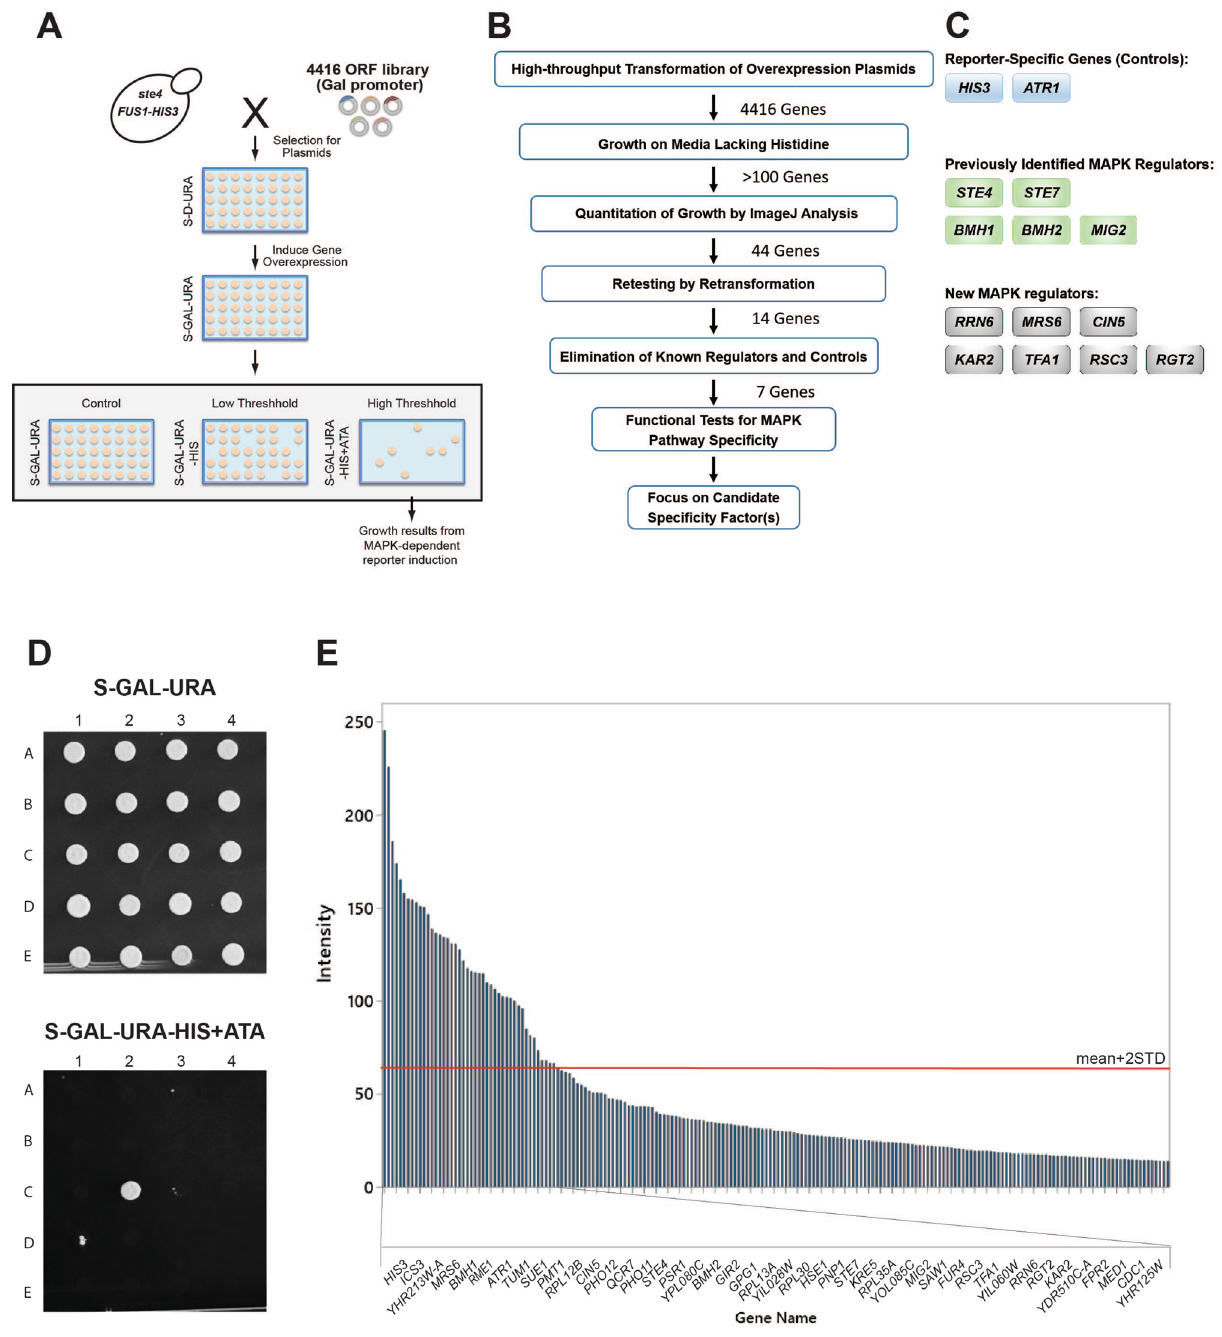
Figure 2. Genome-wide overexpression screen for new MAPK pathway regulatory proteins. (A) Diagram of the overexpression screen. An ordered collection of 4416 ORF overexpression plasmids covering ~ 80% of yeast genome controlled by an inducible ( pGAL1 ) promoter (circles 66 ) was introduced into a ste4 FUS1-HIS3 strain (PC999) by high-throughput transformation. Transformants were generated by a microtiter plate method and pinned onto S-D-URA to select for plasmids. Overexpression of genes was accomplished by pinning colonies from S-D-URA to S-GAL-URA medium to induce overexpression of the genes. On the following day, cells were pinned to low threshold and high threshold (containing ATA, a competitive inhibitor of the His3 enzyme) media to identify genes that induce a MAPK pathway-dependent growth reporter ( FUS1-HIS3 ) on media lacking histidine. The genes, which could overcome ATA, were identified as the candidates that, when overexpressed, can turn the pathway up (colored spots). (B) Pipeline for identifying functionally relevant MAPK pathway regulators. 44 genes were identified and prioritized for further analysis. The validation screen identified 14 genes from the initial screen. (C) The list of 14 genes that induced the MAPK pathway-dependent reporter, FUS1-HIS3 , when overexpressed. Genes fell into three categories (see Table 1 for more details). (D) Example of a portion of one plate from the overexpression screen (the full screen is available in Table S4). The colony growing in the lower panel, C2, overexpresses MRS6. (E) The graph shows the results of the top genes identified by overexpression. Colony growth on S-GAL-URA-HIS + ATA resulting from reporter ( FUS1-HIS3 ) expression was measured by ImageJ analysis. Growth based on spot intensity and determined and plotted in the graph. The top 200 genes are shown. Forty-four genes passed a cut-off of mean + 2STD (red bar) and are labelled